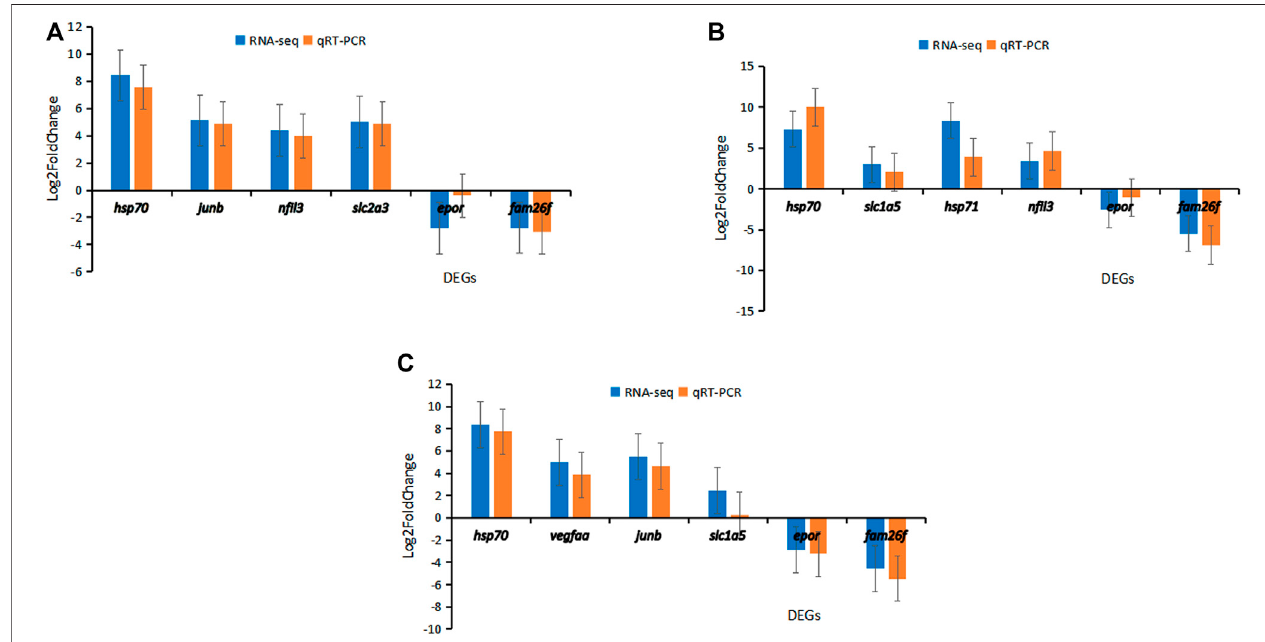
FIGURE7| ResultsofqPCRvalidationforsixDEGsinthreestrainsofcarp. (A) Hebaoredcarpmuscle(MHBH1,MHBH2,MHBH3,MHBH4,MHBH5). (B) Songpu mirror carp liver (LSPH1, LSPH2, LSPH3, LSPH5, LSPH6). (C) Hybrid F1 carp muscle (MF1H1, MF1H2, MF1H3, MF1H4, MF1H5).